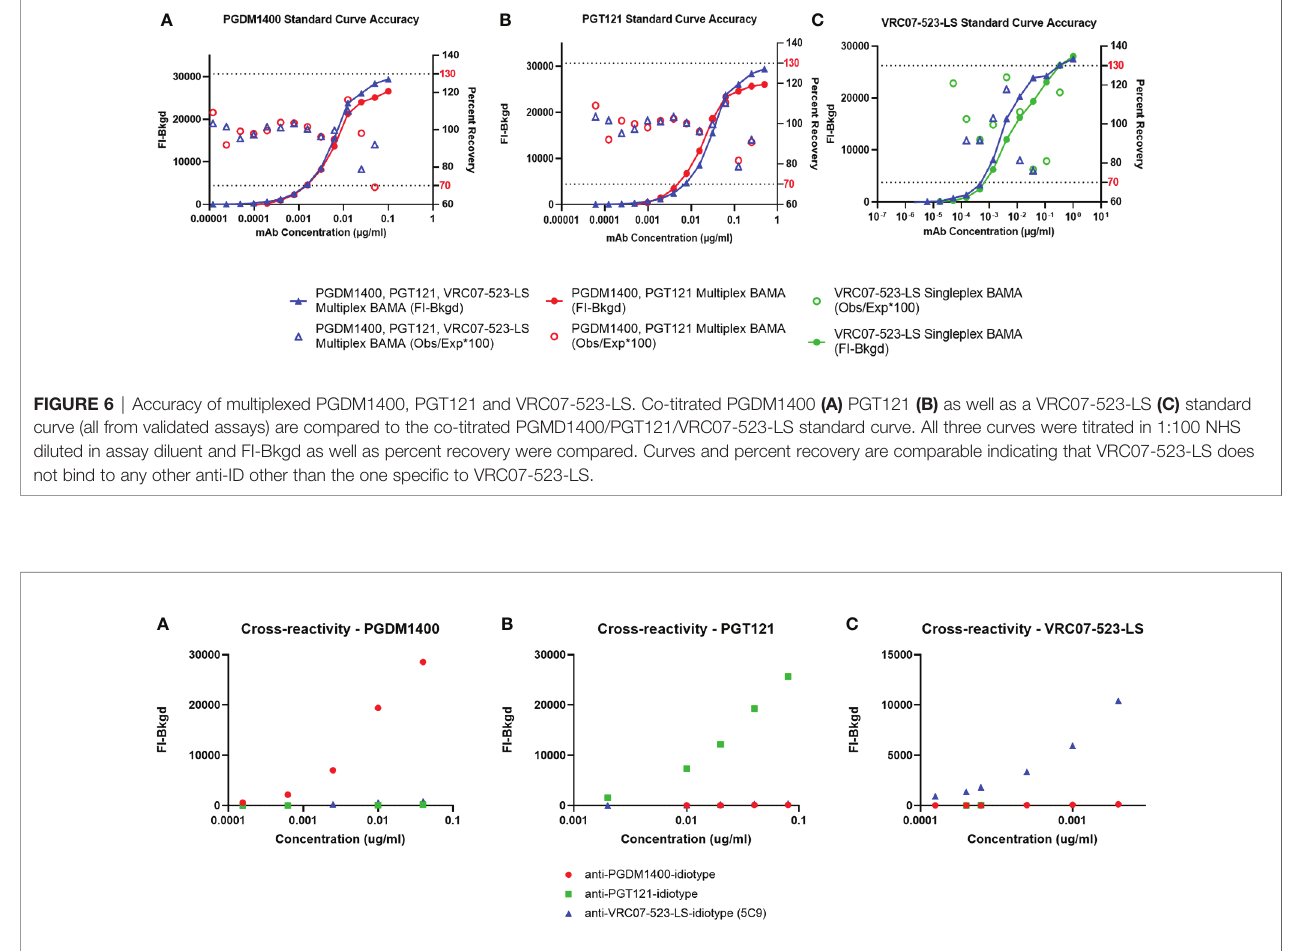
FIGURE 7 | Lack of Cross-reactivity and competition between PGDM1400, PGT121 and VRC07-523-LS and their respective anti-ID antibodies. PGDM1400 (A) , PGT121 (B) and VRC07-523-LS (C) were each titrated in assay diluent and incubated with a microsphere mixture containing all three anti-ID antibodies. Binding can only be observed between speci fi c mAb and anti-ID antibodies, indicating that the anti-ID ’ s are highly speci fi c and no cross-reactivity can be